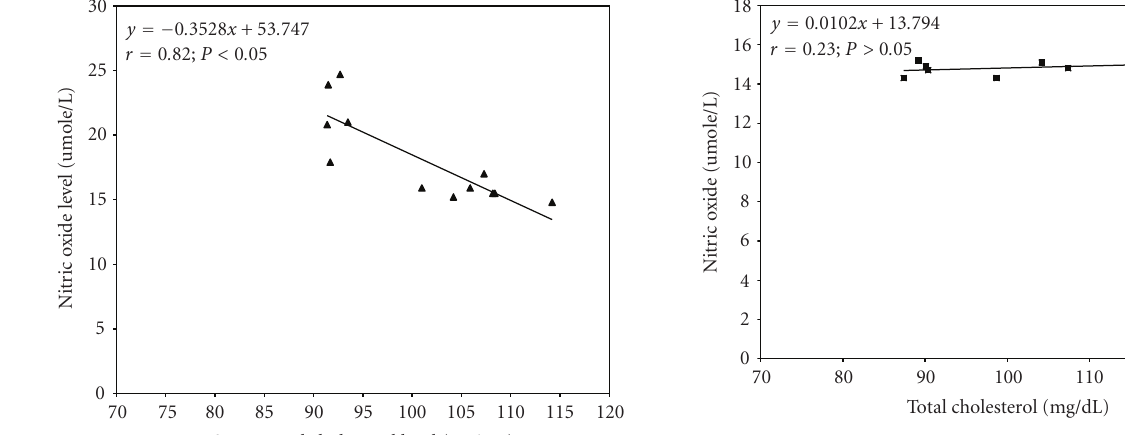
Figure 4: Regression analysis showing the relationship between serum total cholesterol and nitric oxide in the control